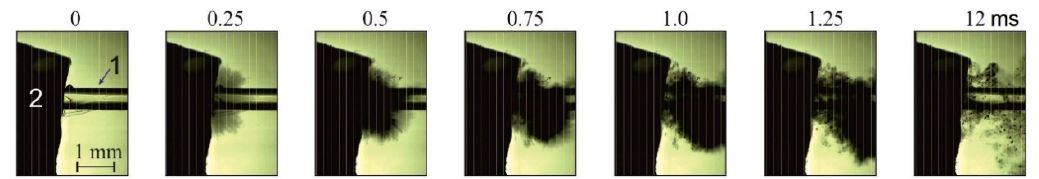
Figure 3. Typical pictures from a high-speed camera taken during the fragmentation of the stone phantom in a dusting regime. 1—laser fiber, 2—phantom of the stone. The time scale is in ms.